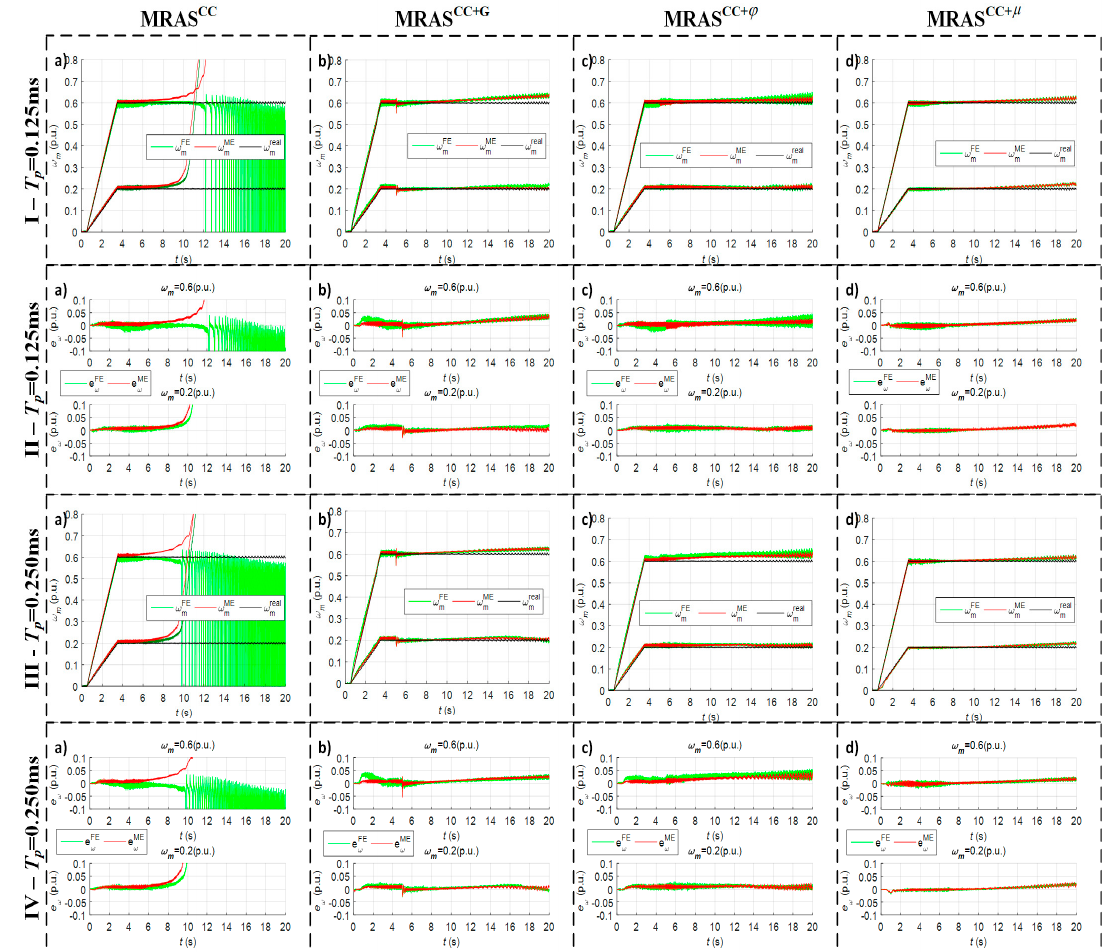
Figure 12. Experimental speed transients for four tested MRAS CC -type estimators in regenerating mode, discretized with FE and ME methods: classical MRAS CC —column ( a ), MRAS CC + G —column ( b ), MRAS CC + ϕ —column ( c ), MRAS CC + µ —column ( d ) for two sampling times: T p = 0.125 ms (row I, II), T p = 0.250 ms (row III, IV); speed transients (row I and III), speed estimation error transients (row II and IV)—experimental results, m L = m LN . Table 4. ITAE criterion values for ω m = 0.2 p.u . and ω m = 0.6 p.u. speeds under regenerating mode—experimental results for Figure 12.